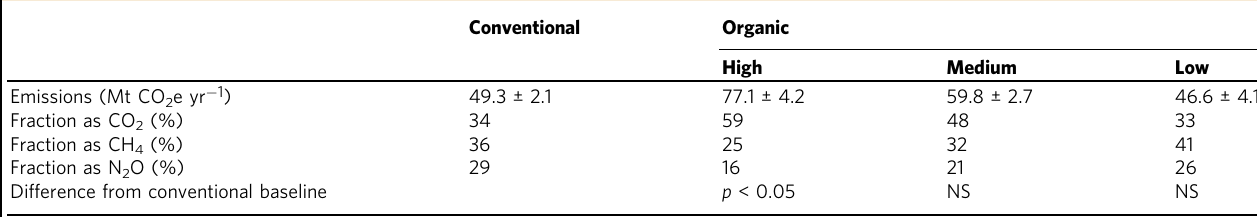
*Data are means ± 1 std.